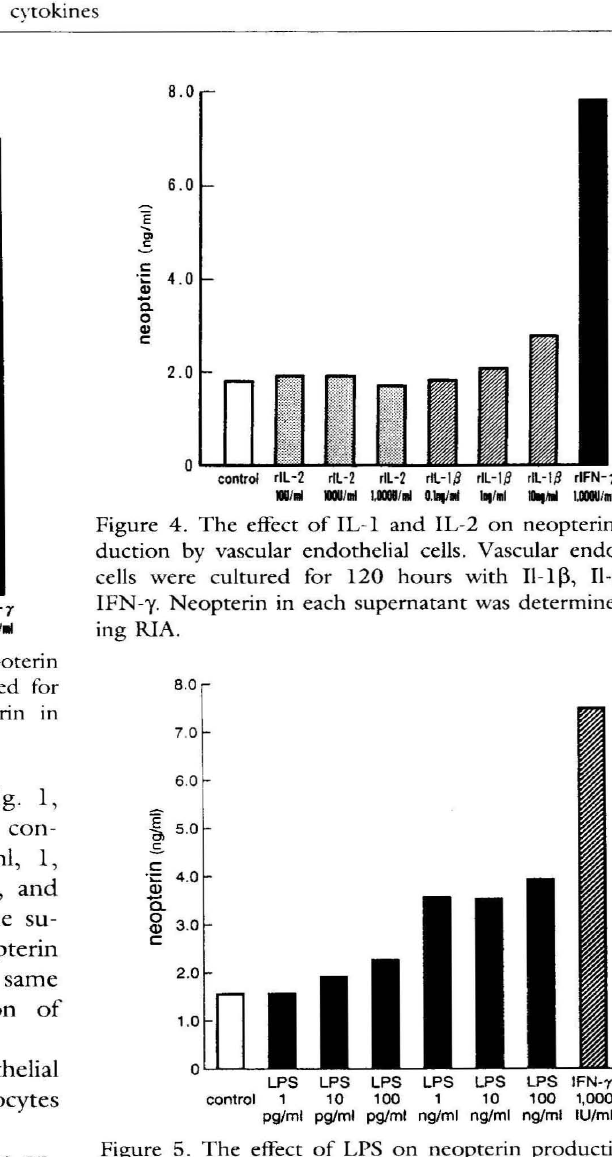
Figure 5. The effect of LPS on neopterin production by monocytes. Monocytes were cultured for 120 hours with LPS, or interferon-yo Neopterin in each supernatant was determined using